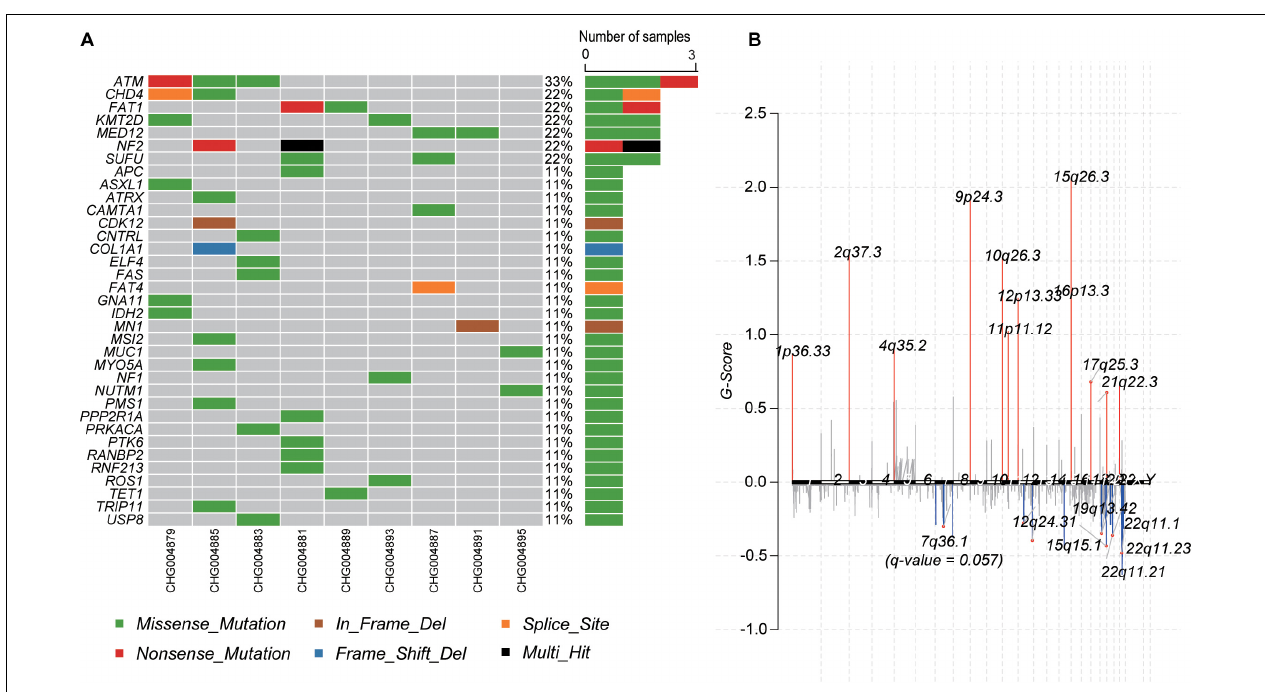
FIGURE 2 | The mutational landscape of spinal schwannoma. (A) The somatic mutations of cancer driver genes across the nine spinal schwannomas. (B) The somatic copy number alterations along the chromosomes. The G-score was to evaluate the significance of the gains and